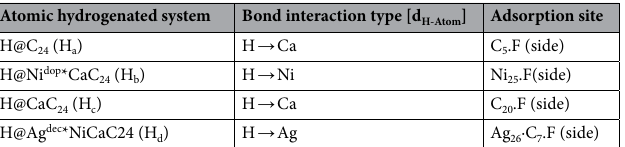
Table 5. Hydrogenated studied systems, and the electronic population of atomic hydrogen at different adsorption sites.